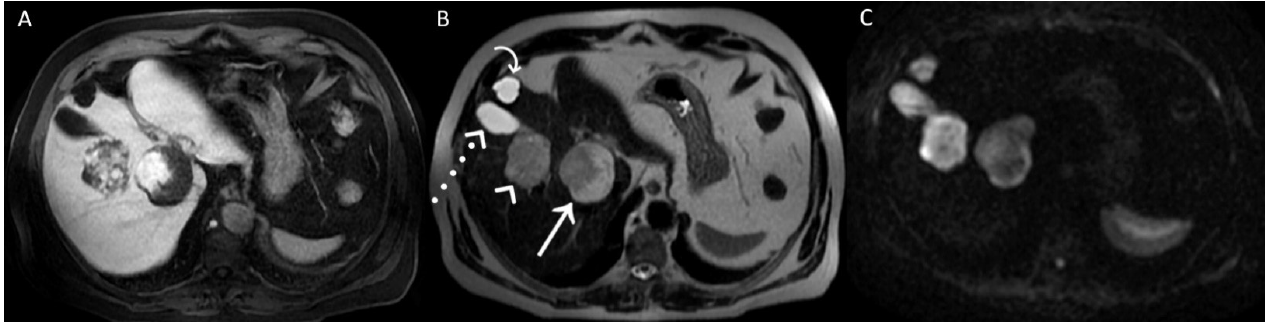
Figure 3. A posteriori, a perfect correspondence between the contrast agent globular enhancement on Axial T1-weighted fat saturated images in delayed phase ( A ) and the relatively hypointense areas on post-contrast T2WI ( B ) and DWI ( C ) was evident. Furthermore, the largest and deepest lesion showed a relatively hypointense area on DWI, larger than that on T2WI, due to later acquisition of DWI and progressive centripetal contrast filling of the lesion. On T2WI ( B ), we can also appreciate the comparison between the signal hyperintensity of different structures: cavernous hemangiomas (arrow and arrowhead); simple cyst (curved arrow), and gallbladder’s fundus (dotted arrow). T2WI and DWI are usually acquired after the acquisition of vascular phases in the dead time until the acquisition